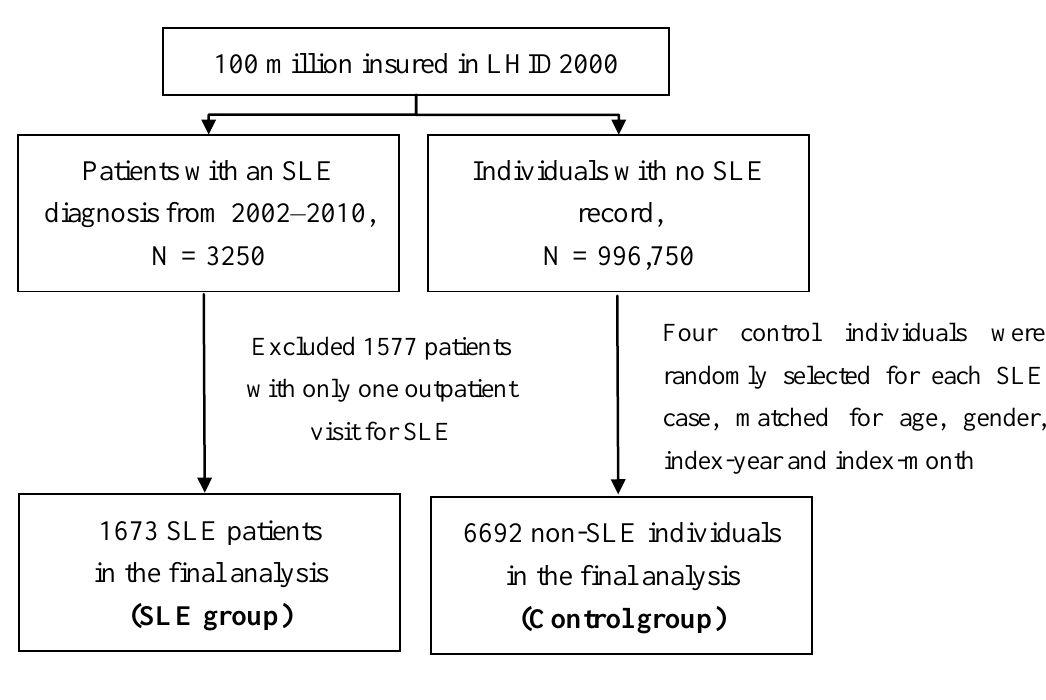
Figure 1. Flow chart for the selection of study